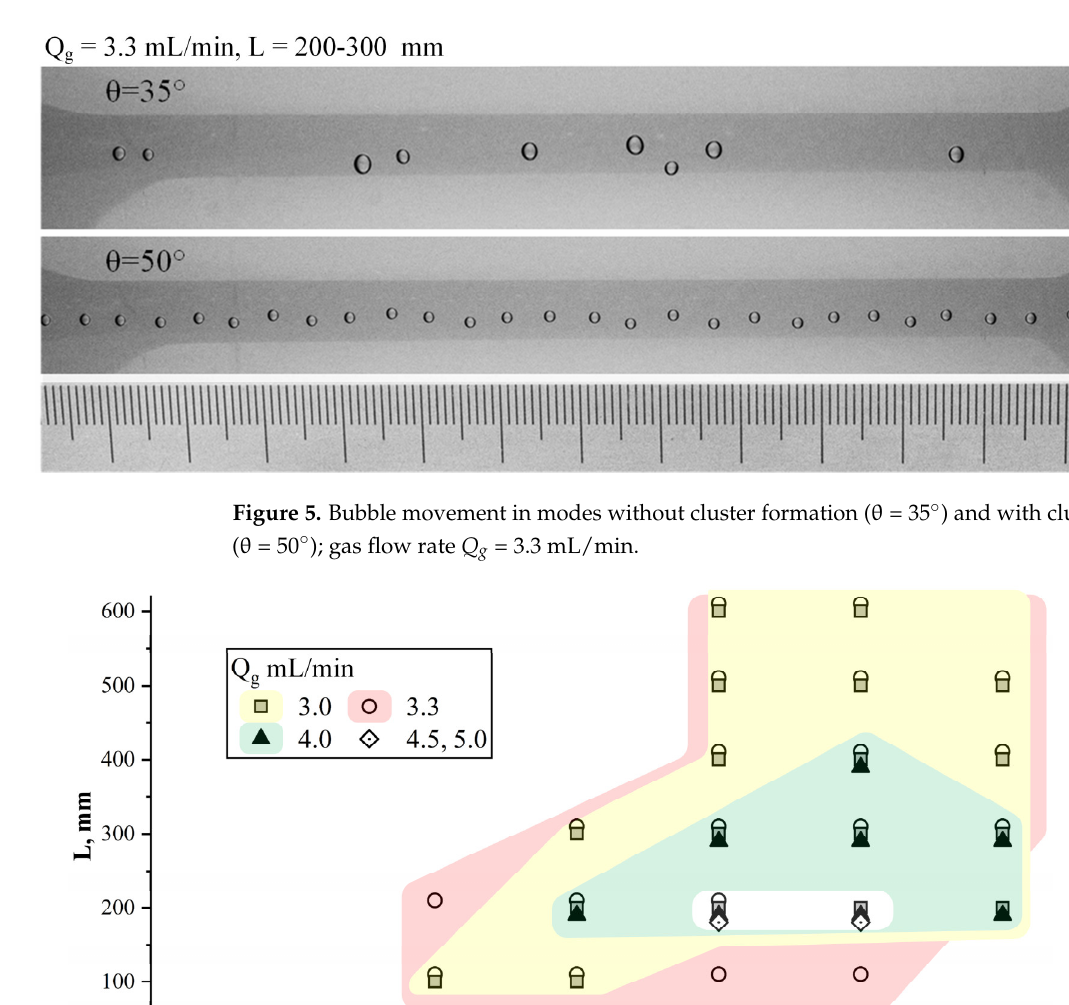
Figure 6. Map of the modes of movement of bubbles. The points correspond to the parameters for which the bubble chain mode appeared.